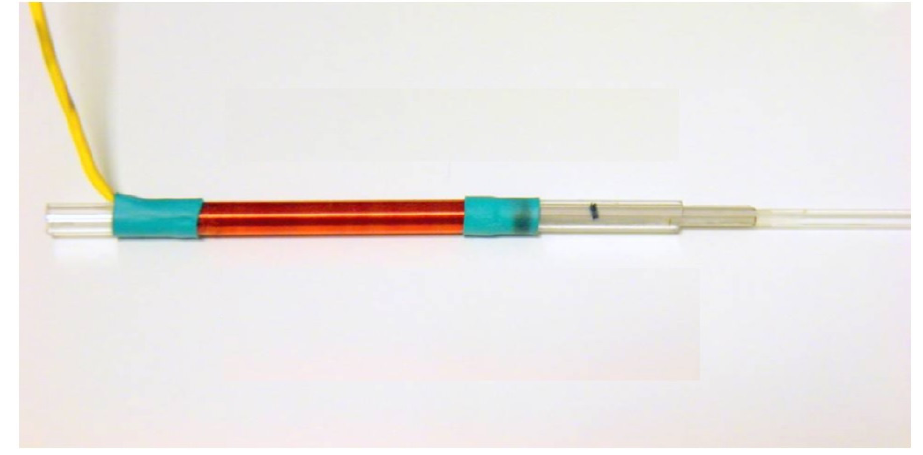
Figure 4. Sliding ferromagnetic